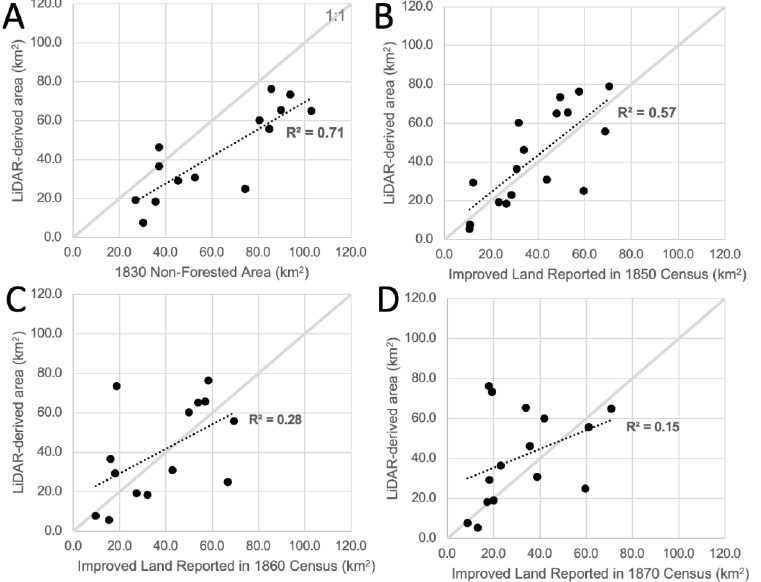
Figure 6. Scatterplots showing the relationship between improved (i.e., non-forested) area from archival records and LiDAR-derived area where stone wall density is greater than 2 km/km 2 in all study towns (black dots) for the years ( A ) 1830, ( B ) 1850, ( C ) 1860, and ( D ) 1870. Note that Monterey, Sandisfield, and Plainfield are not included in the 1860 plot ( C ), and Monterey and Sandisfield are not included in the 1870 plot ( D ). The boundaries of Monterey and Sandisfield changed after 1850, so their areas are not comparable, and Plainfield did not have agricultural census data available for 1860. The gray 1:1 line indicates the location where the estimated area from stone walls is equal to the value recorded in the agricultural census.